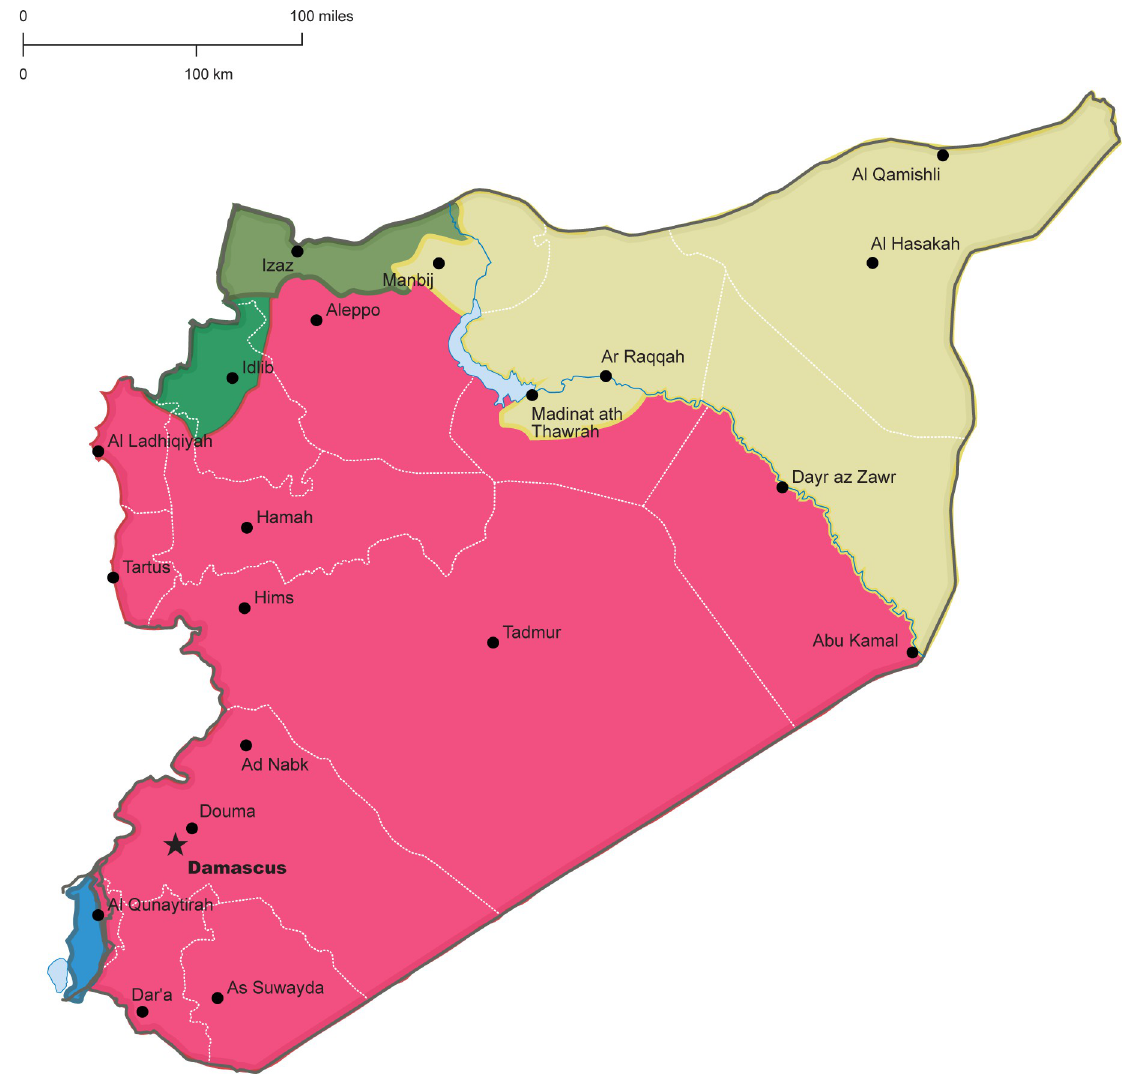
Fig 1. Syria map, indicating main areas of military control. NB: AACA is in yellow; GCA is in red; OCA, along with Turkish-controlled areas, are in green. Source: Noor Albeik, 2022. Additionally, an open access regularly-updated map can be found at https://syria.liveuamap.